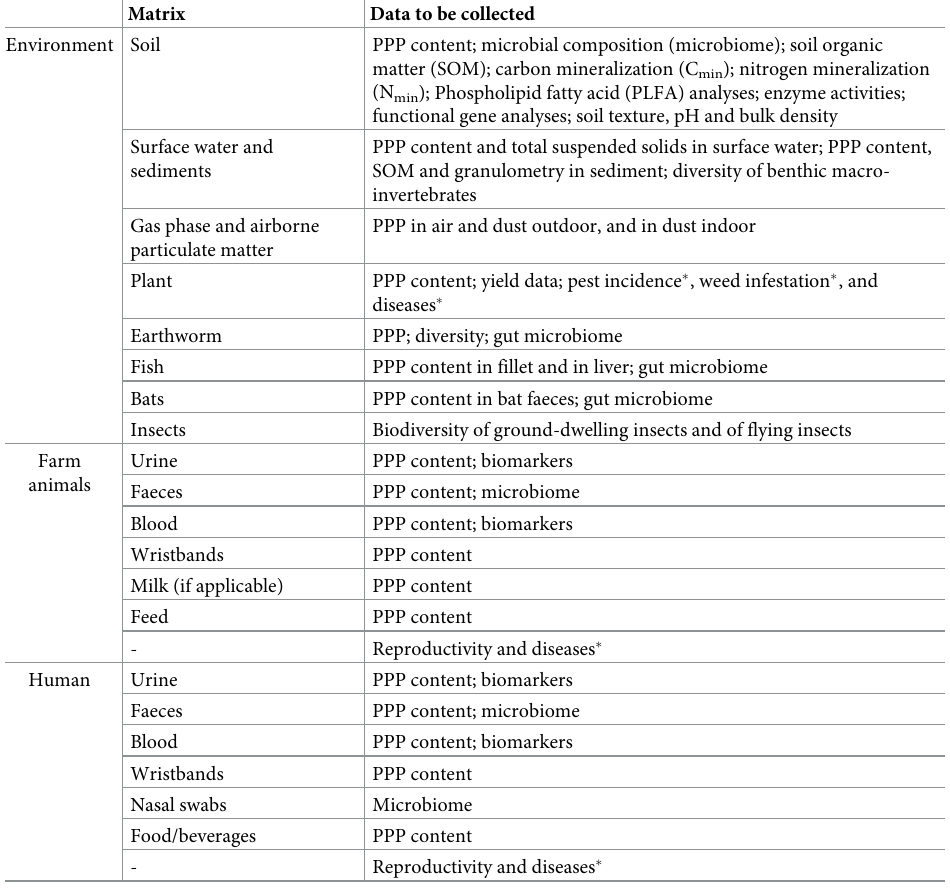
Table 1. Overview of matrices and parameters to be measured or inferred at each